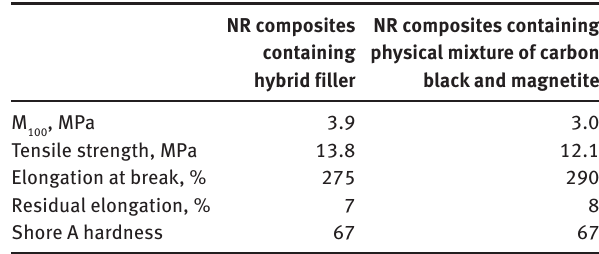
Table 5: Mechanical Properties of composites comprising the hybrid carbon black-magnetite filler and of composites filled with the physical mixture of carbon black and